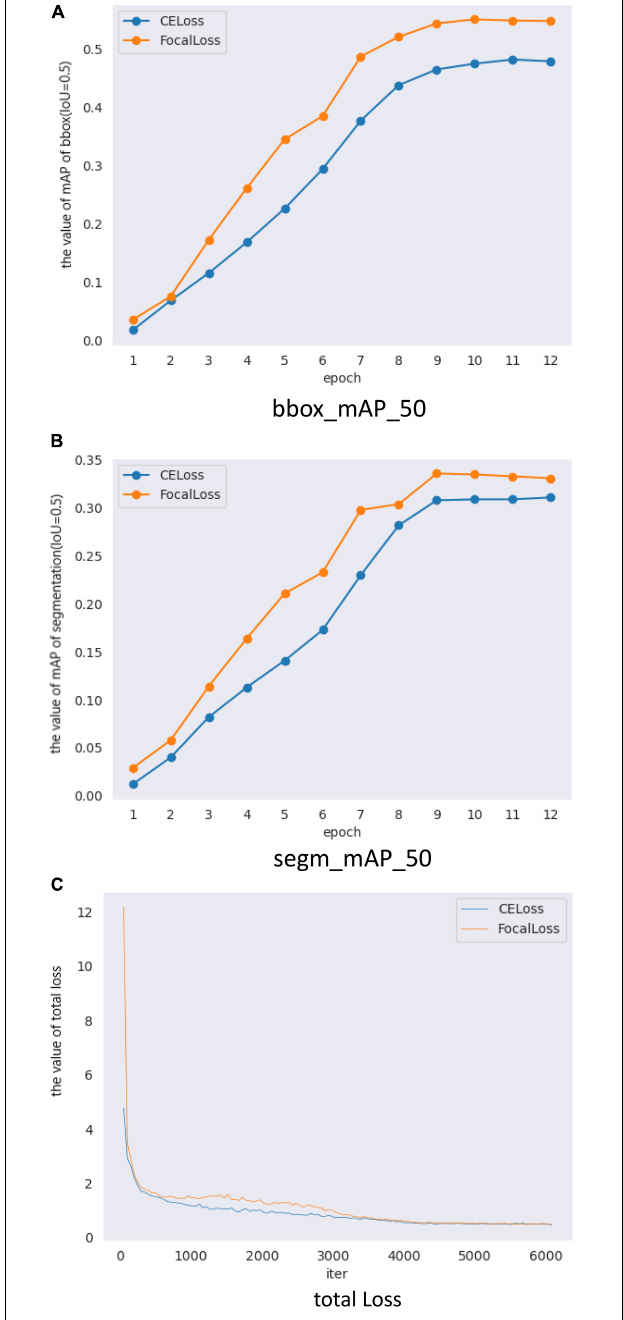
FIGURE 8 | Mask Scoring R-CNN with different loss validation parameters and loss functions. (A) Comparison of mAP_50 of bbox (IoU = 0.5) on different loss, (B) Comparison of mAP_50 of segmentation (IoU = 0.5) on different loss, and (C) Comparison of total loss.